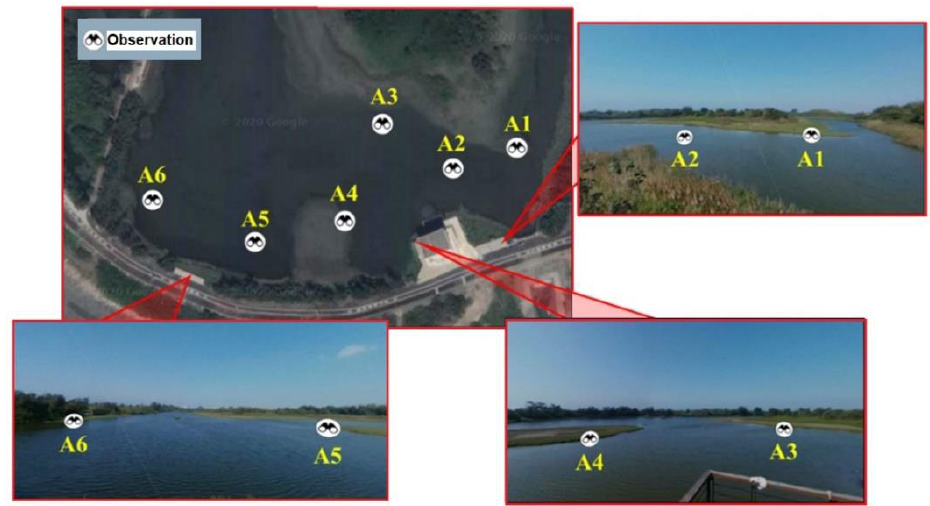
Figure 3. Chin Cheng Lake bird-watching area and its observation points. Table 2. Chin Cheng Lake bird-watching area and its creatures’ characteristics and food sources. Wetland Creatures Characteristics and Food Sources